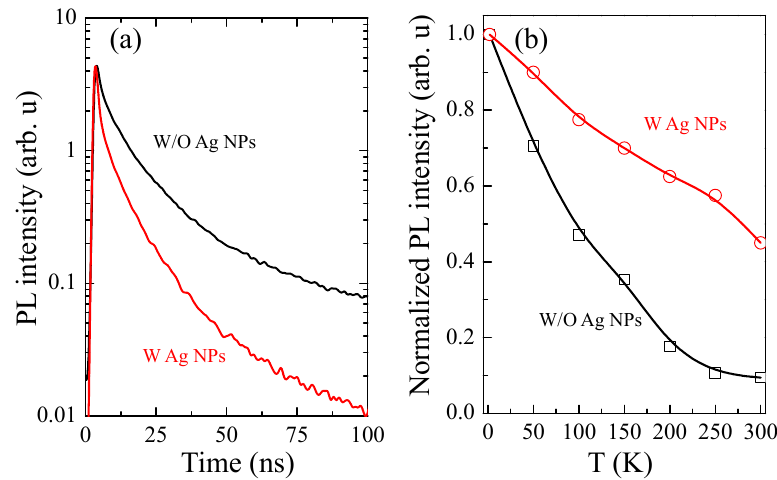
Figure 7. ( a ) Room temperature time-resolved PL (TRPL) and ( b ) Temperature dependent PL measurement of Ag NPs sample 4 and sample 3 without Ag NPs, respectively.